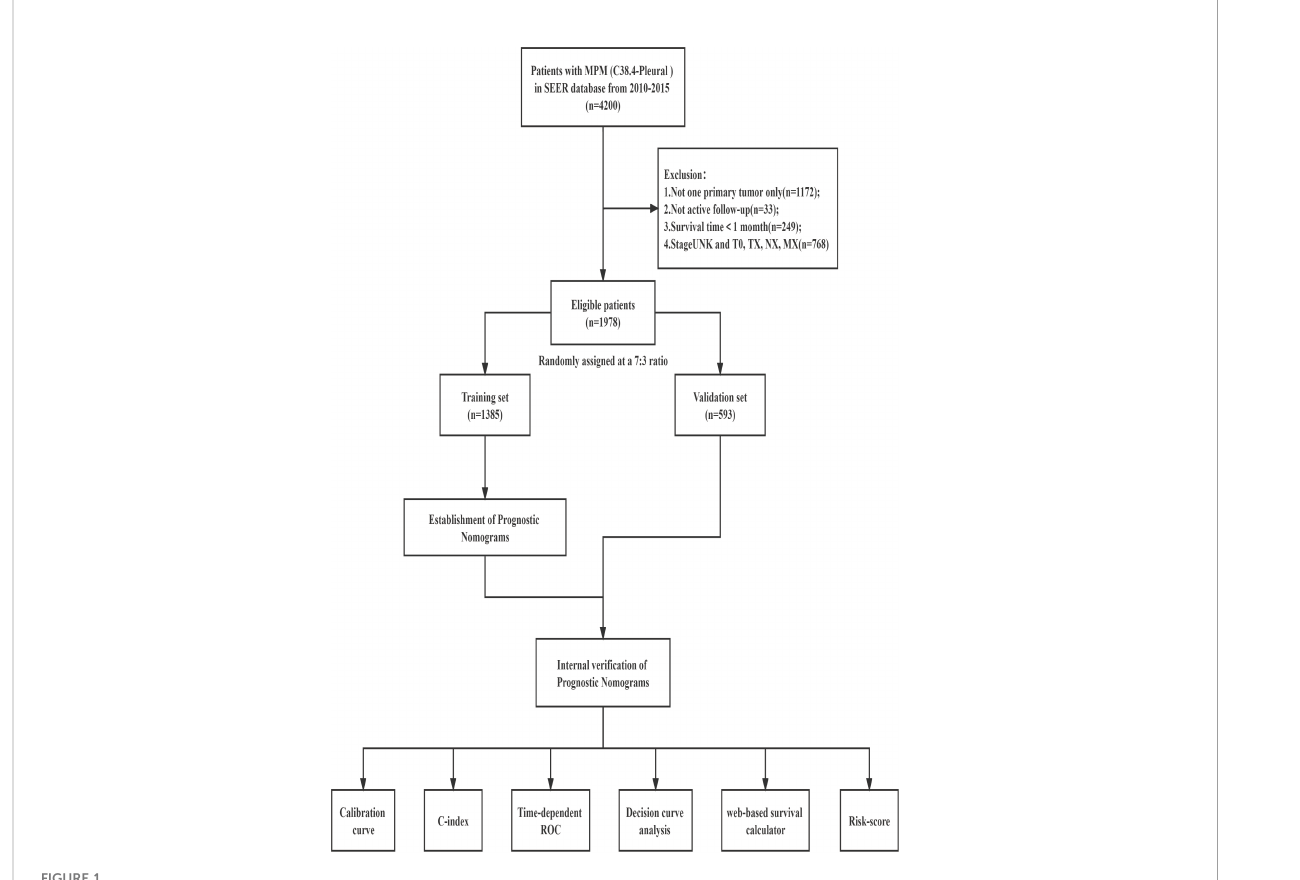
FIGURE 1 Study design and the work fl ow